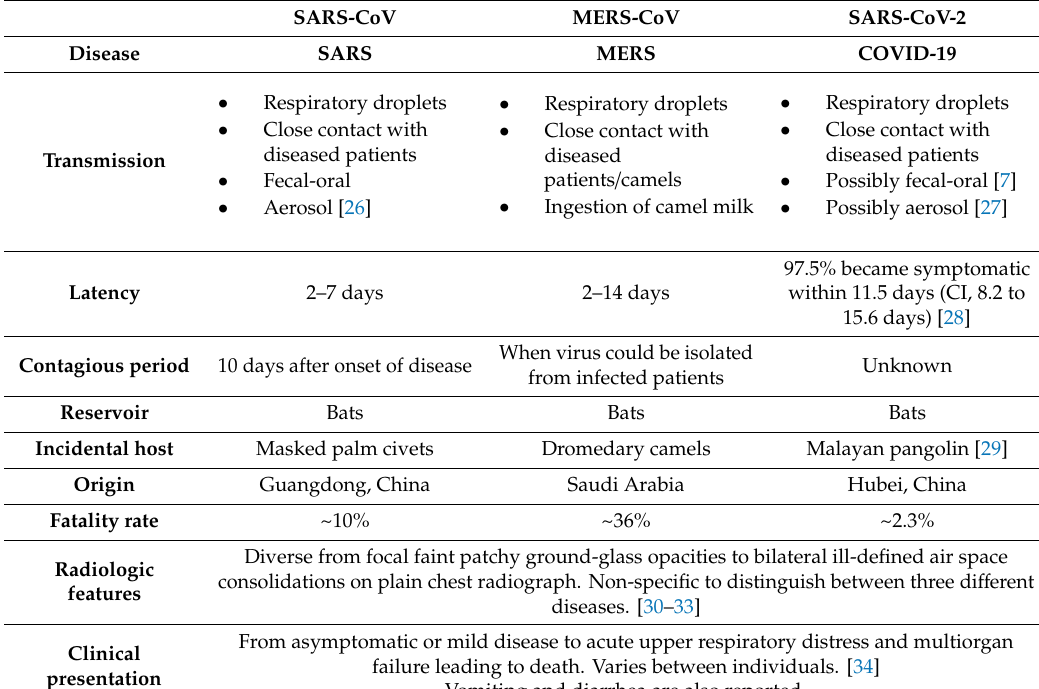
Table 1. Comparison of the epidemiological, clinical and radiological features of the diseases caused by SARS-CoV, MERS-CoV, and